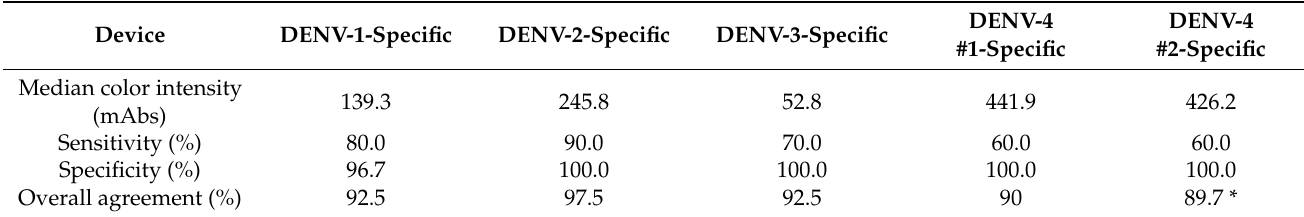
Table 3. Evaluation of DENV serotype-specific devices in DENV-positive clinical serum samples from the Hospital for Tropical Diseases, Bangkok, Thailand, during